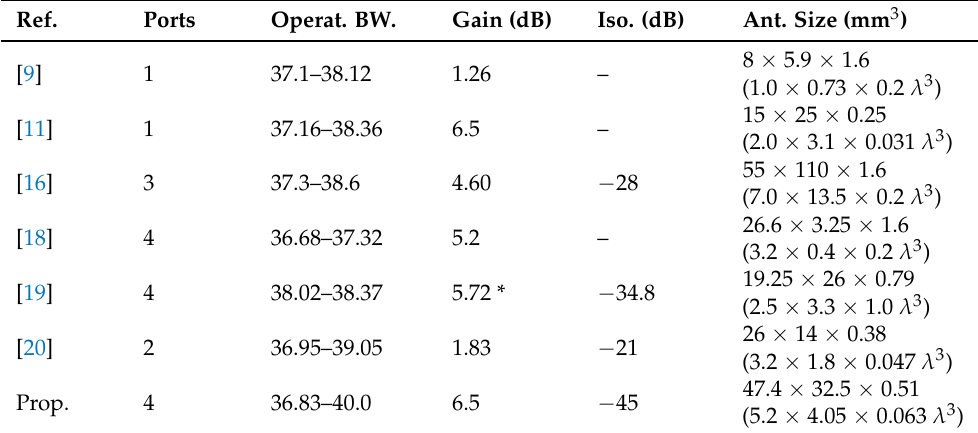
Table 3. Comparison of the proposed antenna performance with state-of-the-art works. Ref. Ports Operat. BW. Gain (dB) Iso. (dB) Ant. Size (mm 3